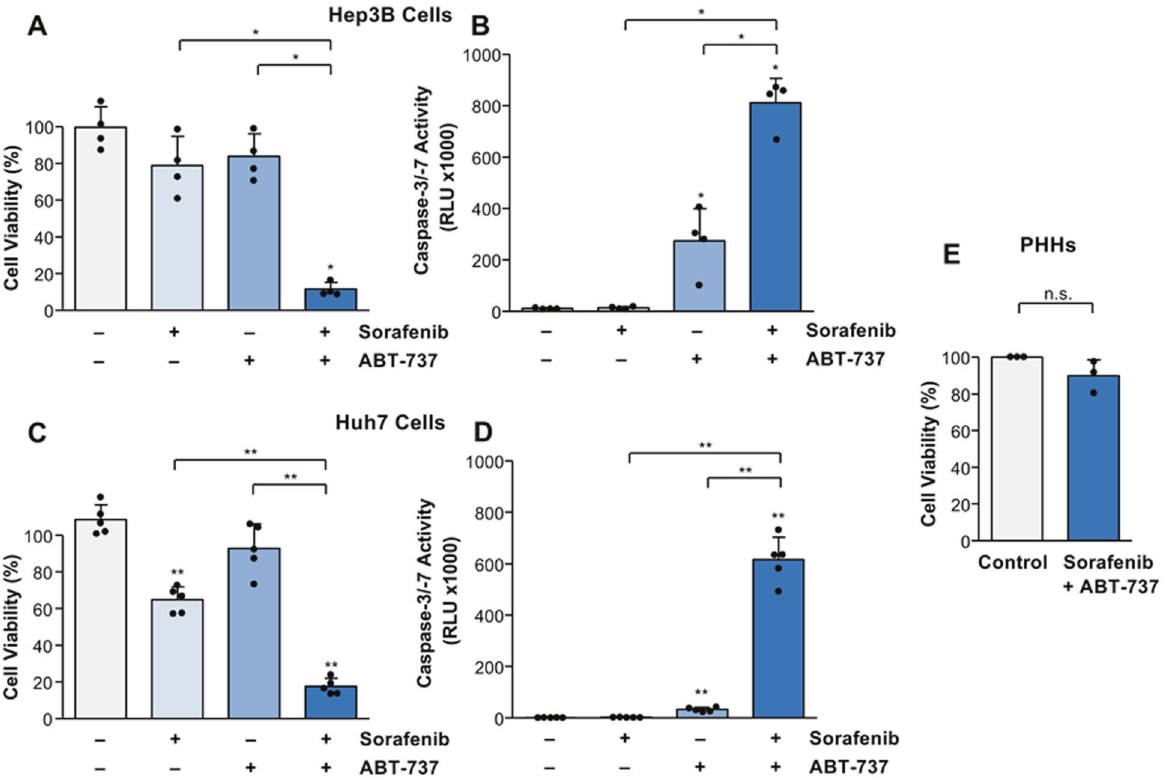
Fig. 4 The BH3-mimetic ABT-737 sensitizes Huh7 and Hep3B cells but not primary human hepatocytes (PHHs) for sorafenib-mediated cell death and caspase activation. A Treatment of Hep3B cells for 8 h with sorafenib (7.5 µg/ml) or ABT-737 (5 µM) alone did not signi fi cantly reduce cell viability in Hep3B cells, whereas their combination strongly increased cell death. B Compared to the respective agents alone, combined treatment (8 h) of sorafenib and ABT-737 increased caspase-3/-7 activation in Hep3B cells. C In contrast to Hep3B cells, sorafenib signi fi cantly reduced cell viability in Huh7 cells, which was even more pronounced by the combination with ABT-737. D Whereas no caspase activation was observed by sorafenib treatment alone, its combination with ABT-737 signi fi cantly induced caspase-3/-7 activation in Huh7 cells. E Compared to untreated cells, treatment of PHHs (obtained from three different donors) for 8 h with sorafenib and ABT-737 did not induce cell death. Results of four ( A , B ) and fi ve ( C , D ) independent experiments are shown. Signi fi cances above the bars refer to control. * p < 0.05; ** p < 0.01; n.s. non-signi fi